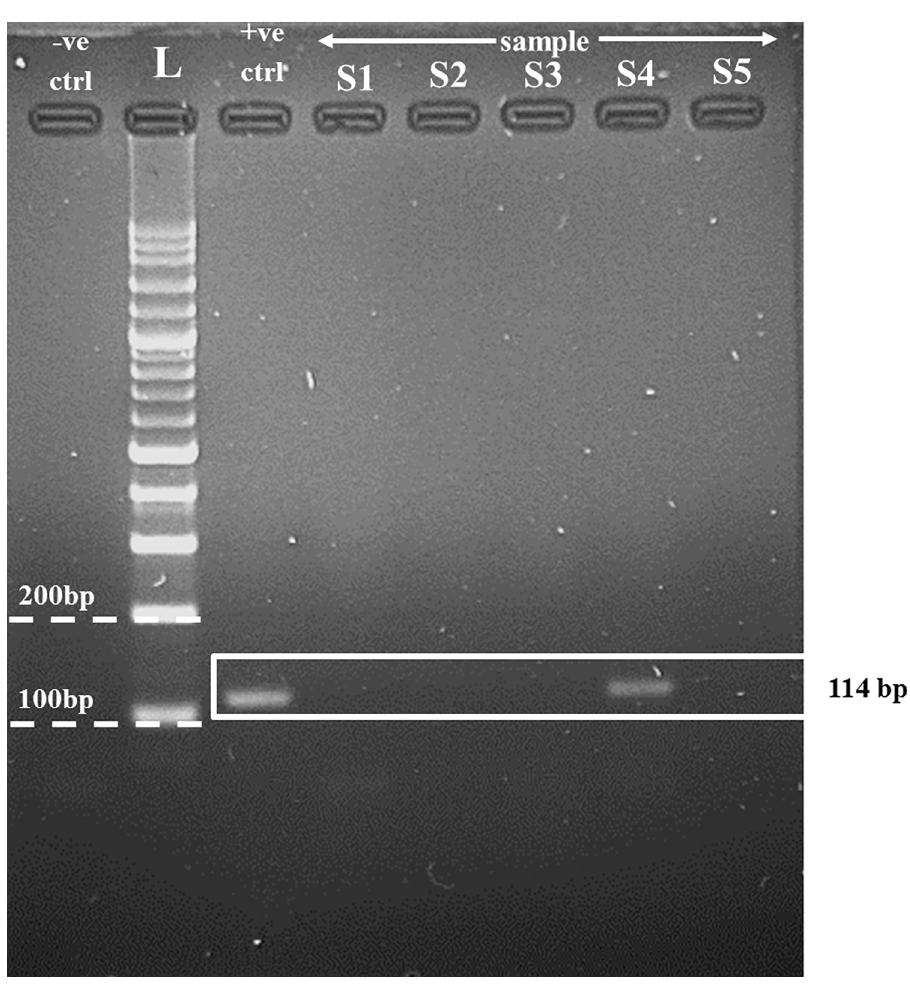
Fig 2. Bands of positive mosquito samples from the gel electrophoresis procedure. The expected target size is 114 bp, targeting capsid and pre-membrane genes of the WNV. The gel was prepared with 1.5% agarose gel electrophoresis (w/v). Key: L: 100 bp size ladder; +ve ctrl: negative control (deionised distilled water); +ve ctrl: positive control (WNV plasmid); S1–S5: pooled samples of female Cx . vishnui